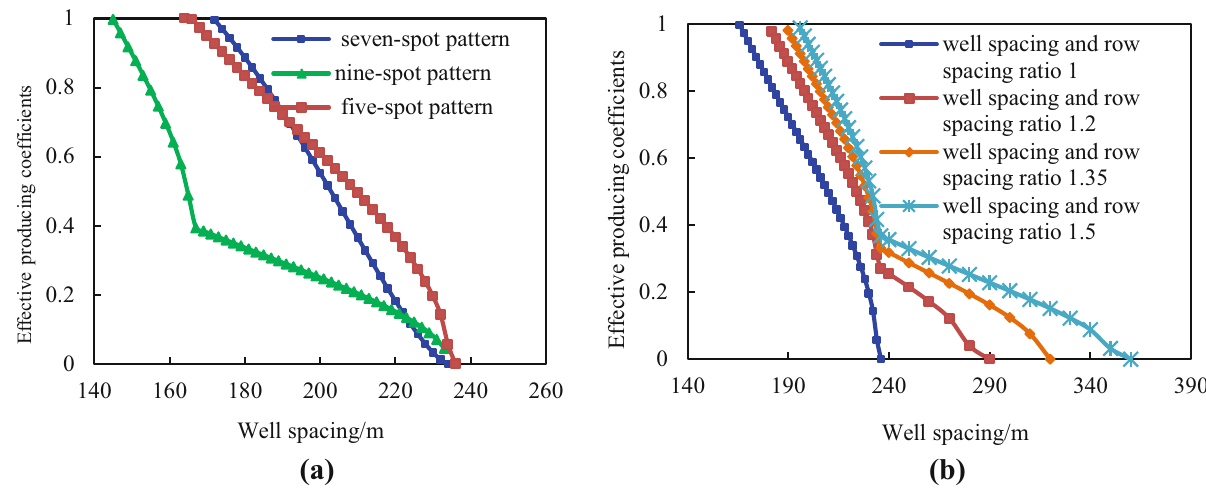
Fig. 12 Well spacing compared to the calculated effective producing coefficients for three different well-spot patterns ( a ) and for various well spacing and row spacing ratios ( b